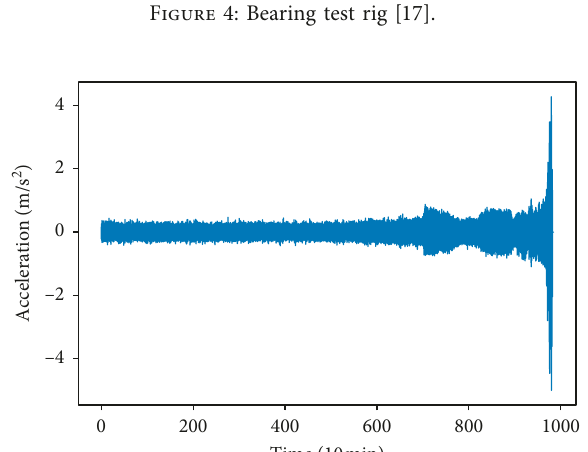
Figure 4: Bearing test rig [17].